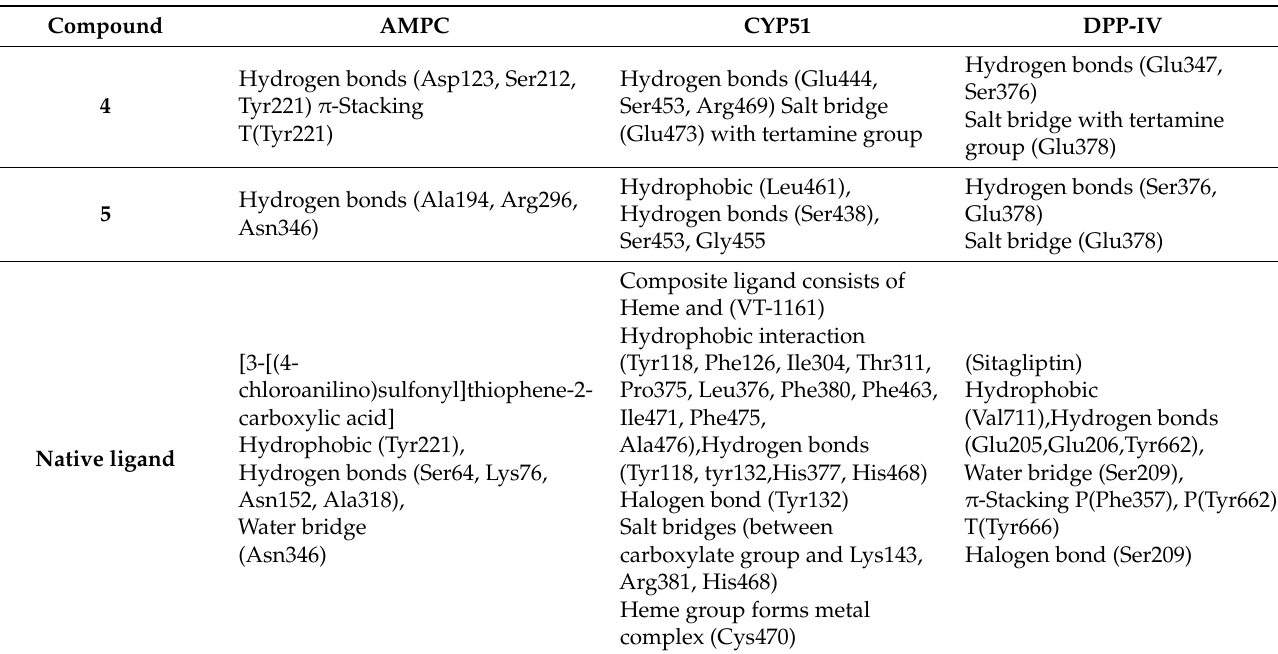
Table 6. The docking poses analysis of interaction complexes using PLIP of synthesized compounds 4 and 5 as well as native ligands against each of the three targets AMPC, CYP51 and